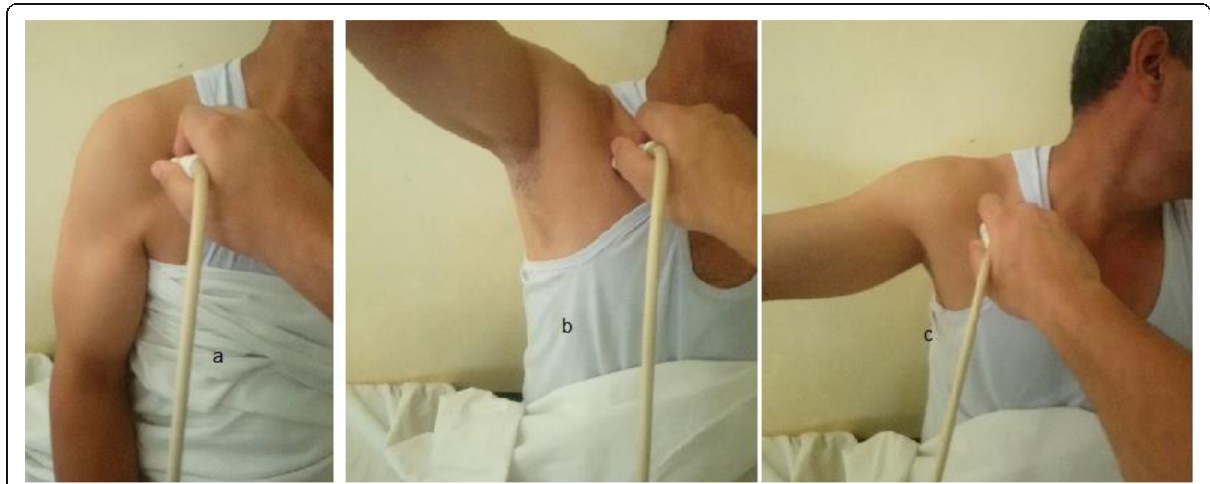
Fig. 1 Photographic images for the patient positioning and exposure in neutral arm position ( a ) in arm abduction and external rotation (ABER) ( b ) and in arm abduction with turning the face to the contra-lateral side (Adson ’ s test) ( c